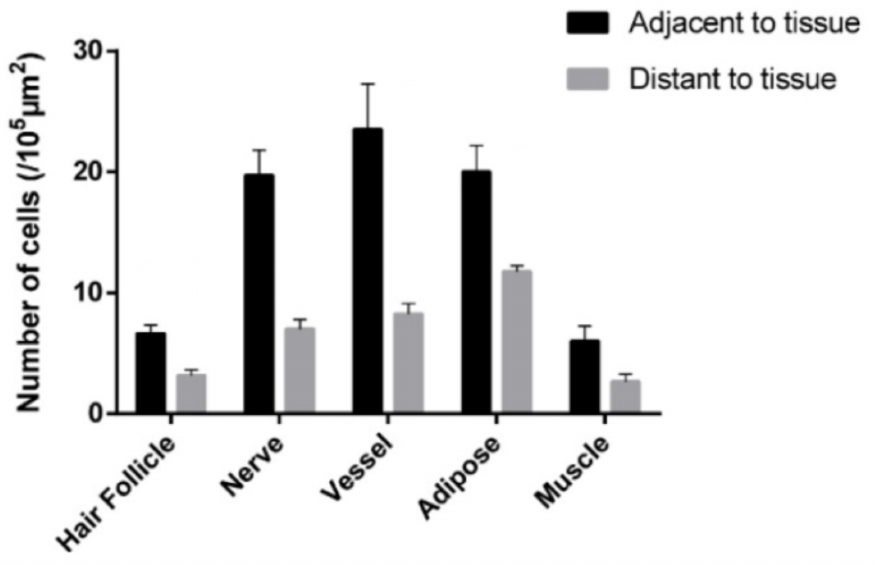
Figure 3. The distribution of rat MCs along adipose and muscle tissues. ( a , b ) MCs are distributed along adipose tissue. Adipose tissue is dyed yellow with gathered particles and marked by white asterisks ‘*’ in the figures. ( c , d ) MCs are distributed along the muscle tissue. The muscle tissue is dyed blue or dark blue and marked by white pound signs ‘#’ in the figures. MCs around the tissue boundaries are marked with dark blue arrows, and the scale bar is shown in the lower right-hand corner of each examined figure. Based on Yang et al. (2018) [20], with permission from Ivyspring International Publisher.